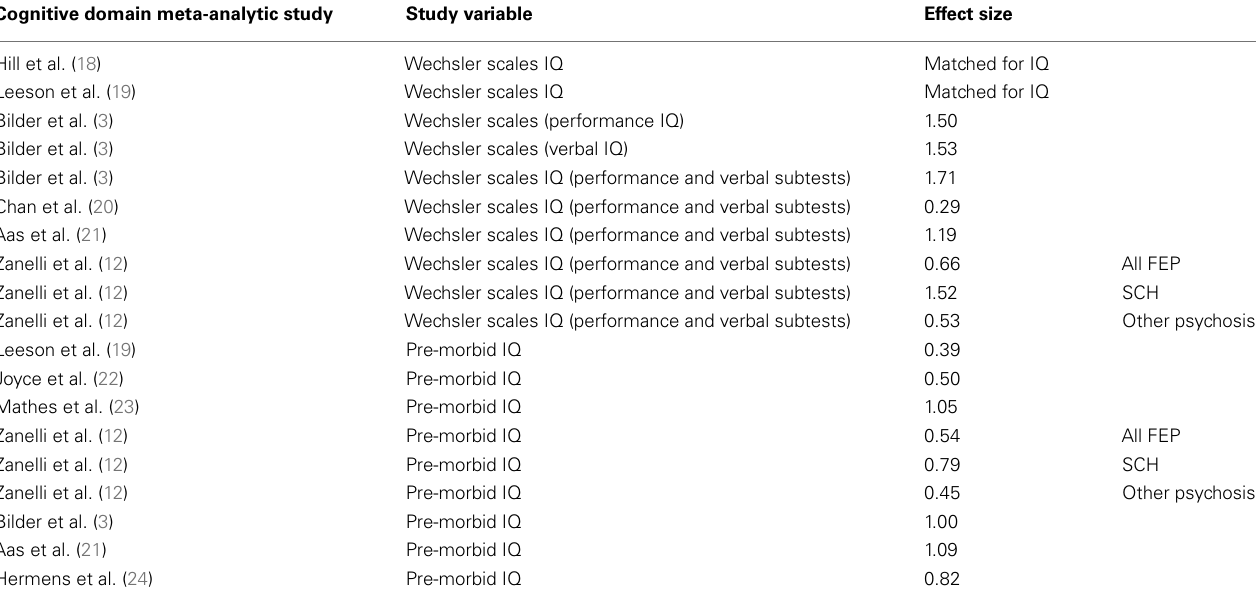
Table 1 | Studies comparing patients with first-episode psychosis and healthy controls on general cognitive ability